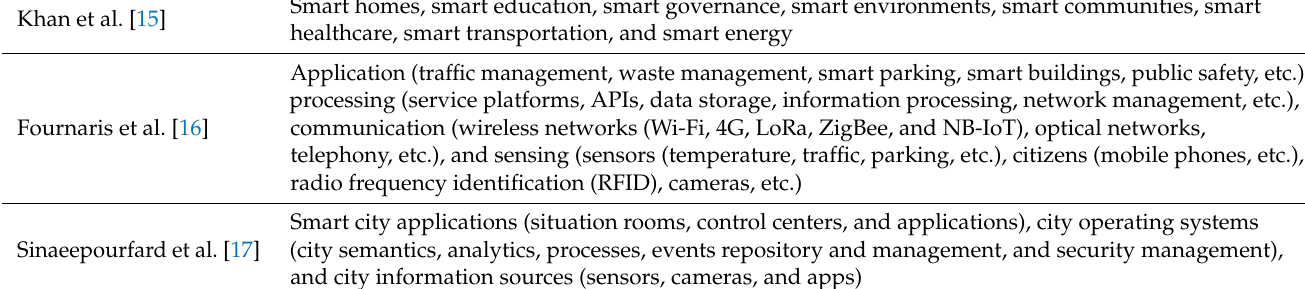
Table 1. The key elements of smart cities derived from the literature. Ref.